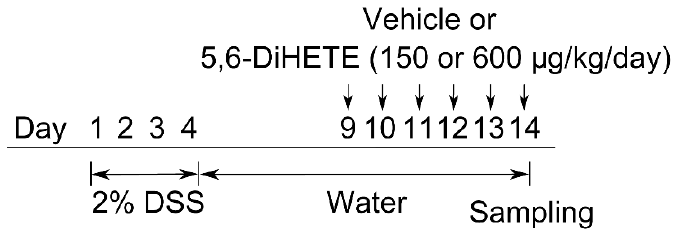
Figure 4. Schematic of experimental design. Colitis was induced by 4 days administration of DSS (2%, w / v ) in drinking water. These mice received normal water from day 5. From day 9 to 14, we orally administered DSS-induced colitis mice 150 µ g/kg/day (n = 8) or 600 µ g/kg/day (n = 9) of 5,6-DiHETE or vehicle (n = 8). Naive mice were fed with normal water and received no treatment throughout the experiment (n = 5). Body weight and faecal condition were assessed every day. On day 14, mice colons were dissected for histological assessment.